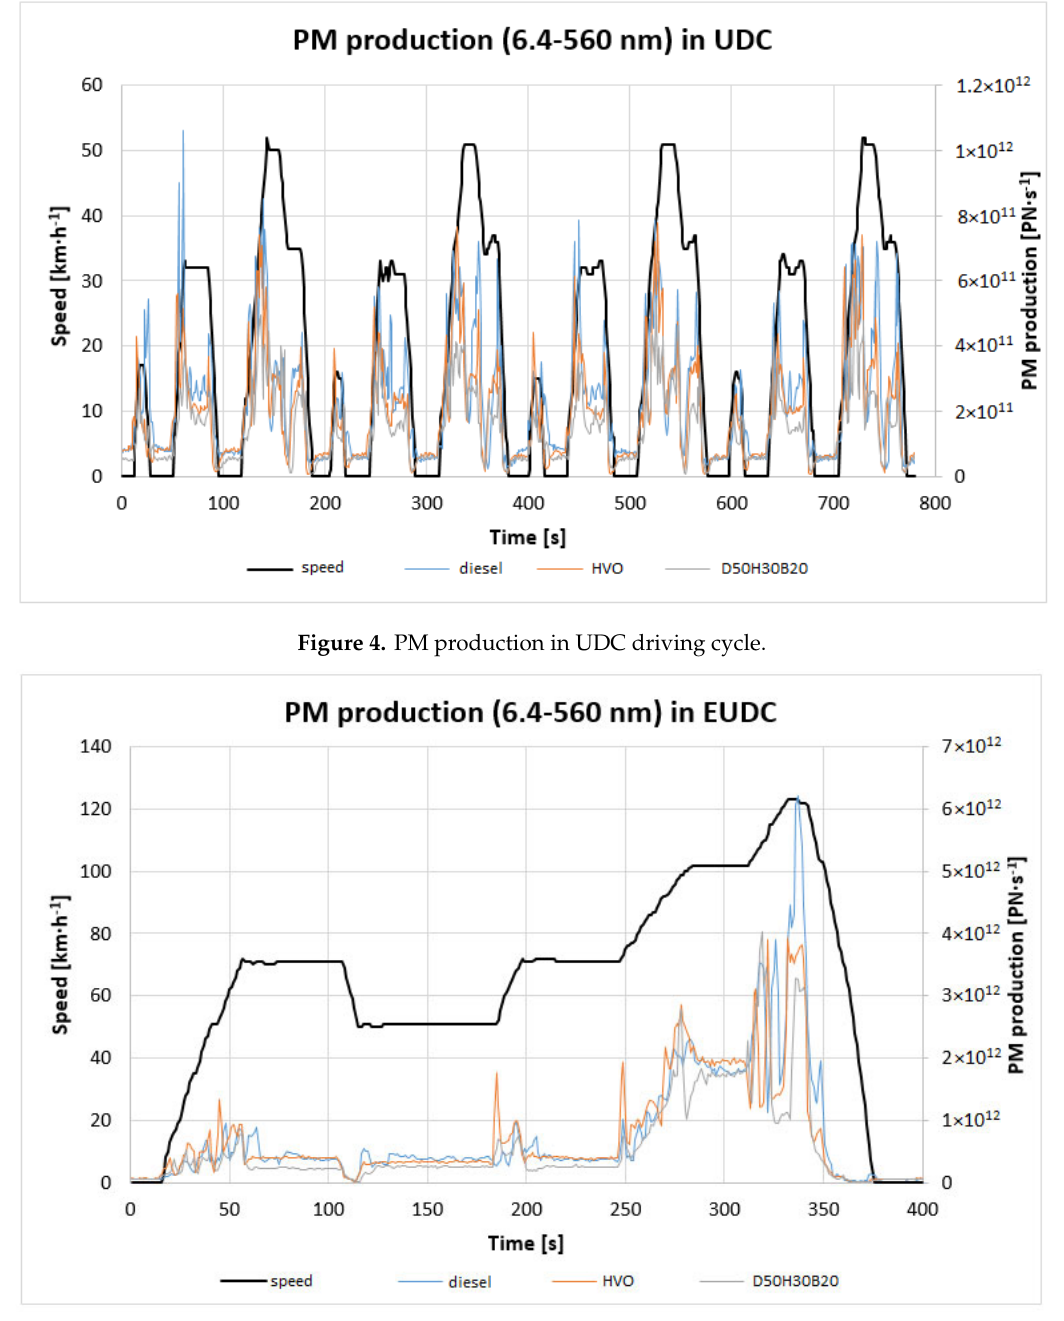
Figure 5. PM production in EUDC driving cycle.